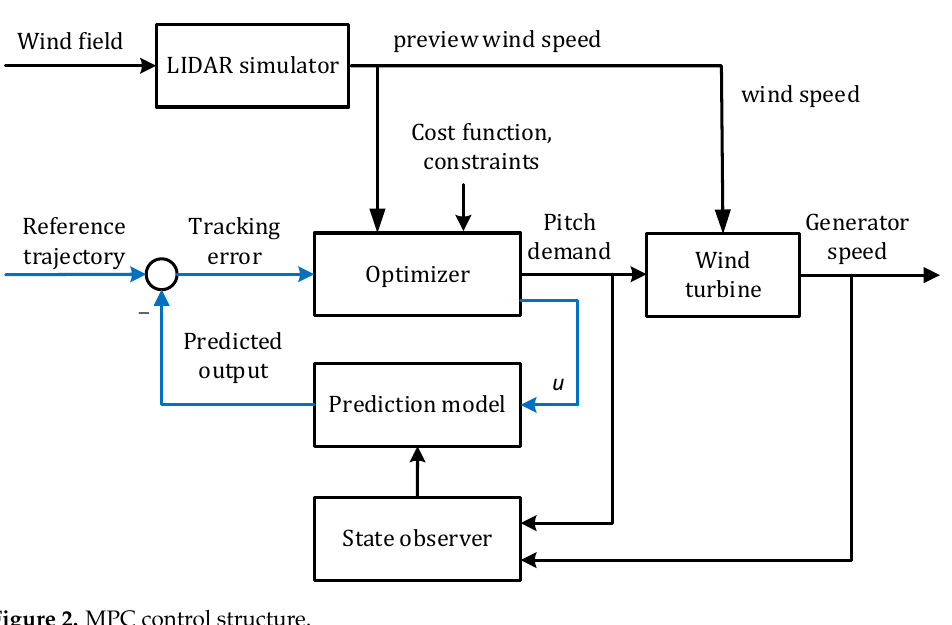
Figure 2. MPC control structure.